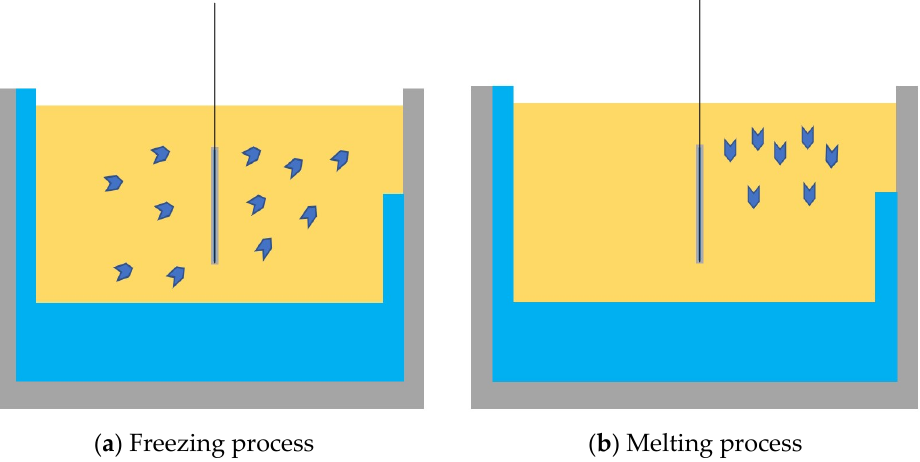
Figure 18. Schematic diagram of freeze ‒ thaw moisture migration.